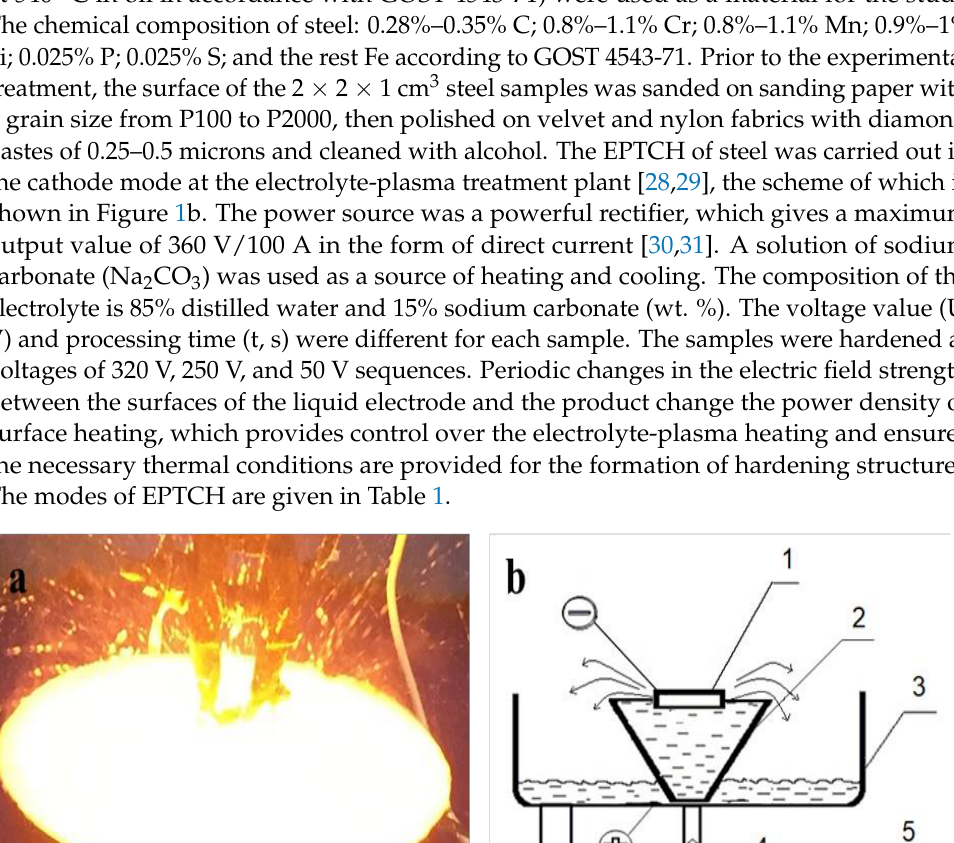
Table 1. Technological parameters of the modes of EPTCH steel 30CrMnSiA.